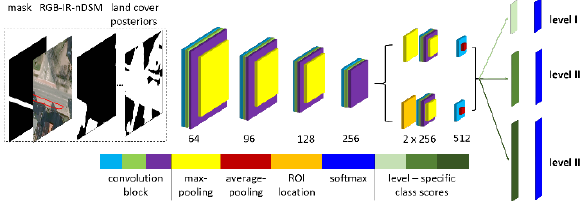
Figure 2. Main architecture of LuNet-MT for B = 3 semantic levels (level I / coarsest level - level III / finest